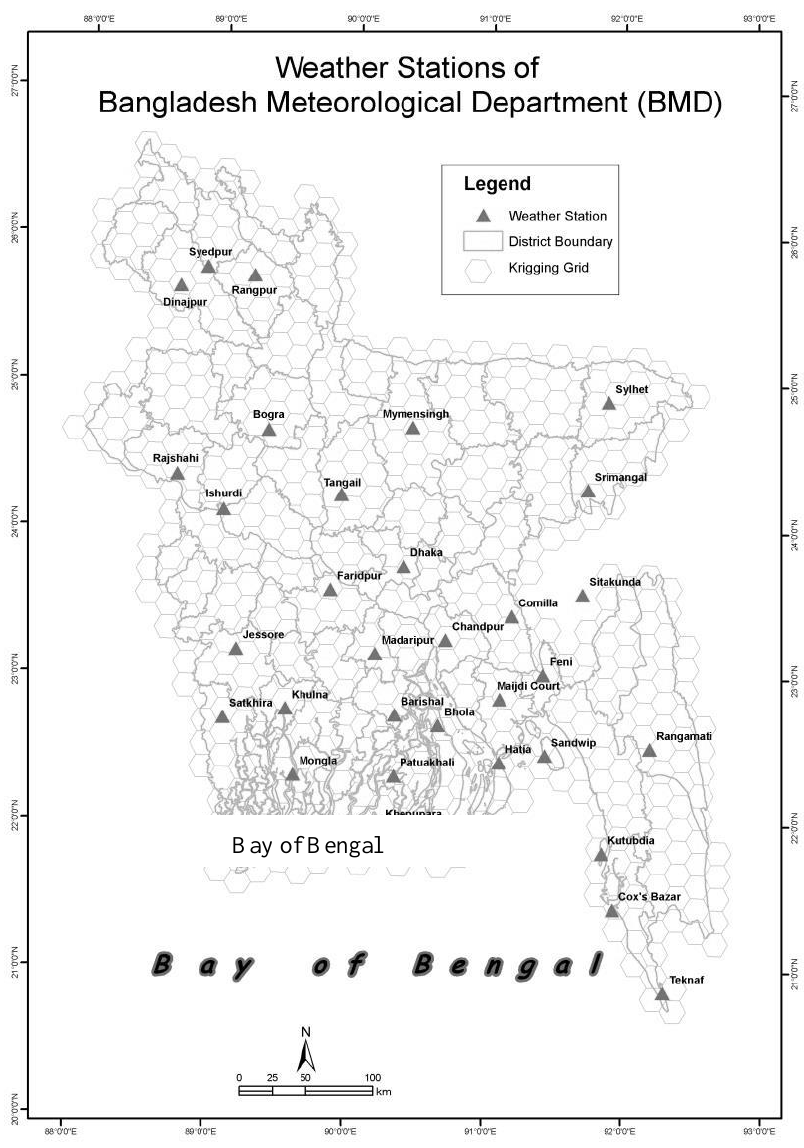
Figure 2. Geostatistical Kriging Mess for interpolation of missing values for the study area.